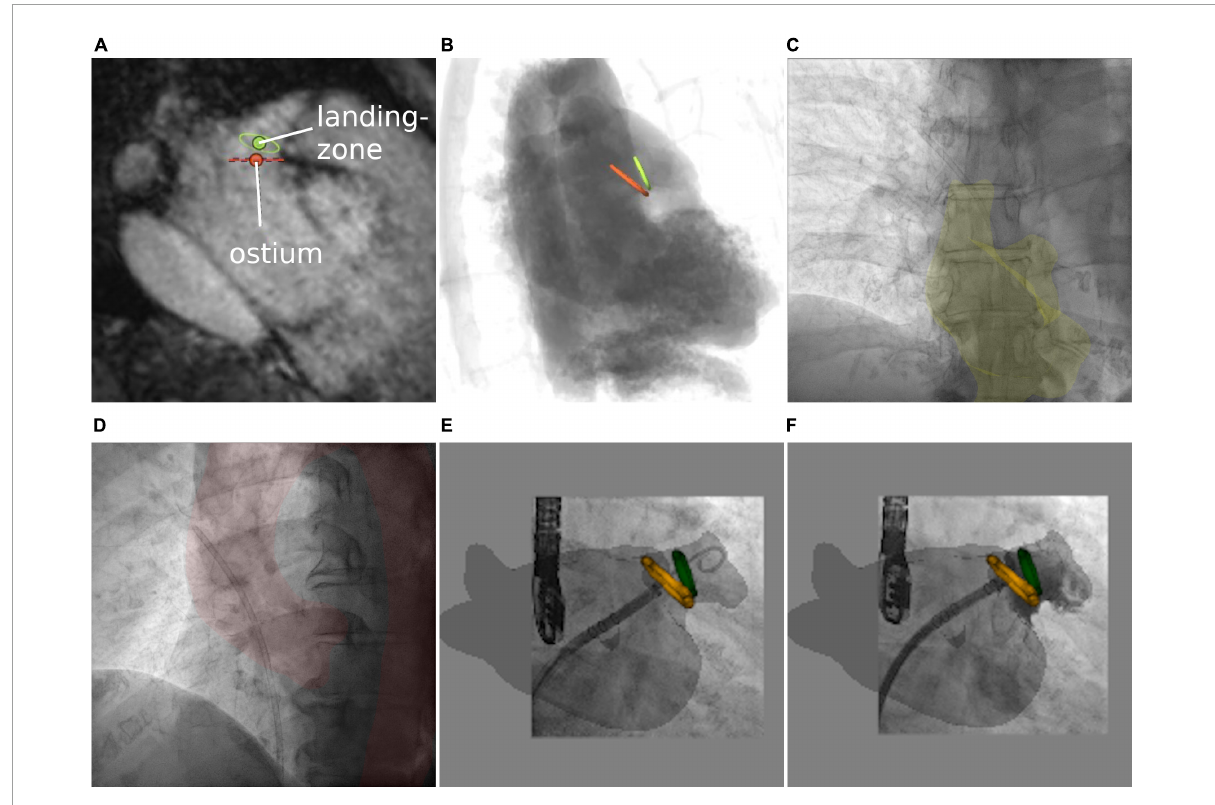
FIGURE6 Left atrial appendage occlusion. (A) MRI-based assessment of left atrial appendage (LAA) shape and diameters. (B) Angiographical simulation including defined ostium (orange) and landing zone (green). (C,D) Manual registration based on right atrium and aortic arch. Image fusion includes planning details during the approach to the LAA (E) and after occlusion (F)